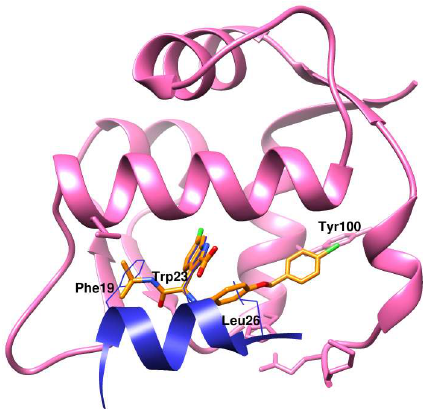
Figure 1. The selected target protein MDM2 in complex with transactivation domain of p53 (shown in blue color, residues Phe19, Trp23, Leu26, and Tyr100 are labelled) and ligand when bound occupies the same binding site (PDB accession code: 1YCQ and 4MDN used for representation).